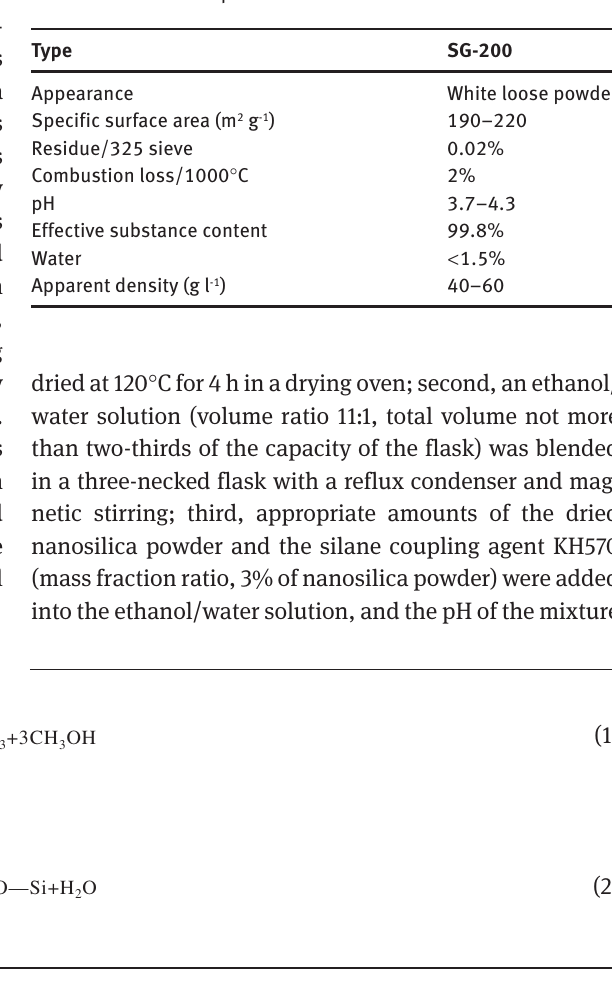
Table 1 Performance parameters of nanosilica.